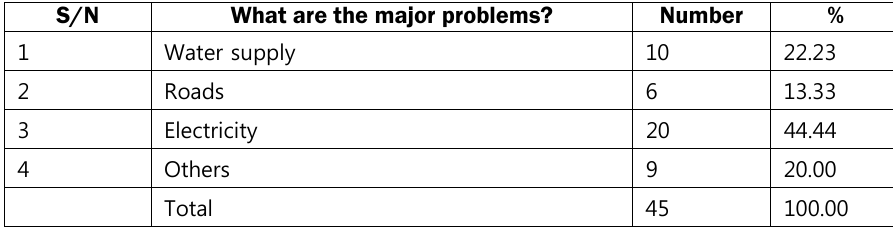
TABLE 9: Officials’ views about the general problems faced by citizens in the city S/N What are the major problems?